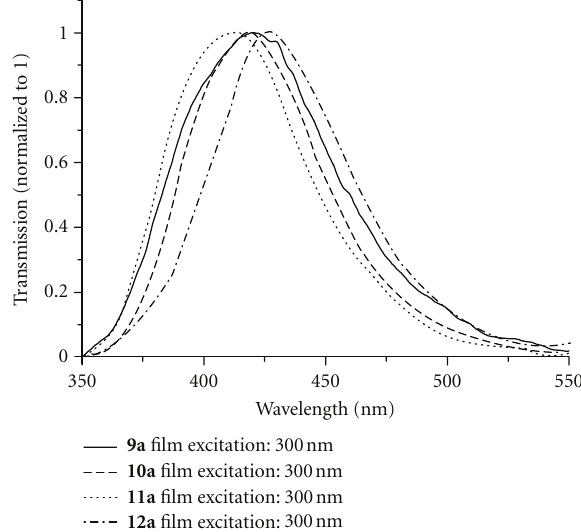
Figure 6: PL spectra of metapolymer films 9a – 12a on silica